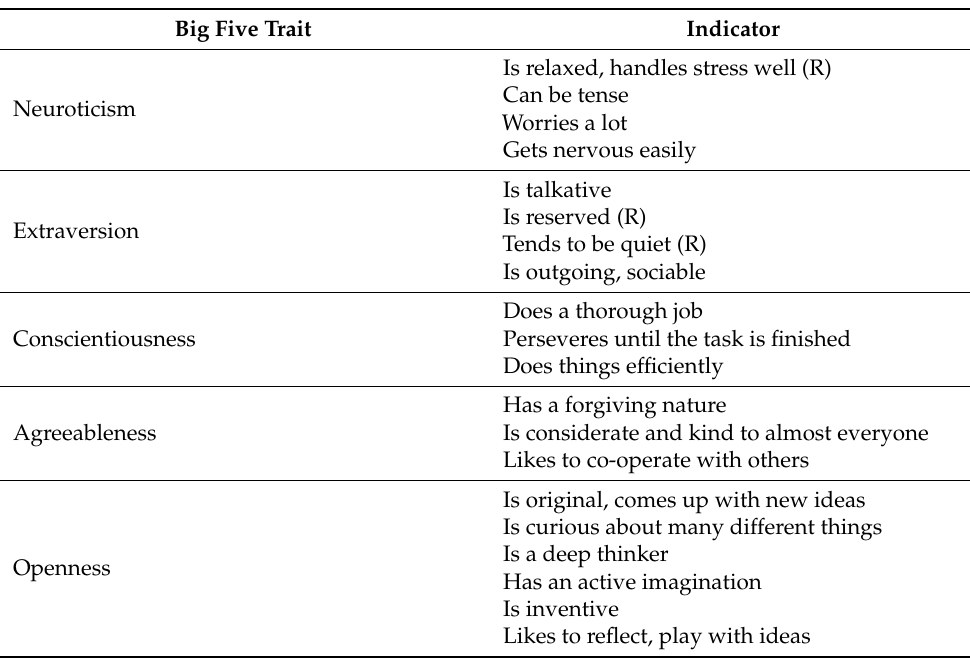
Table A1. Personality indicator